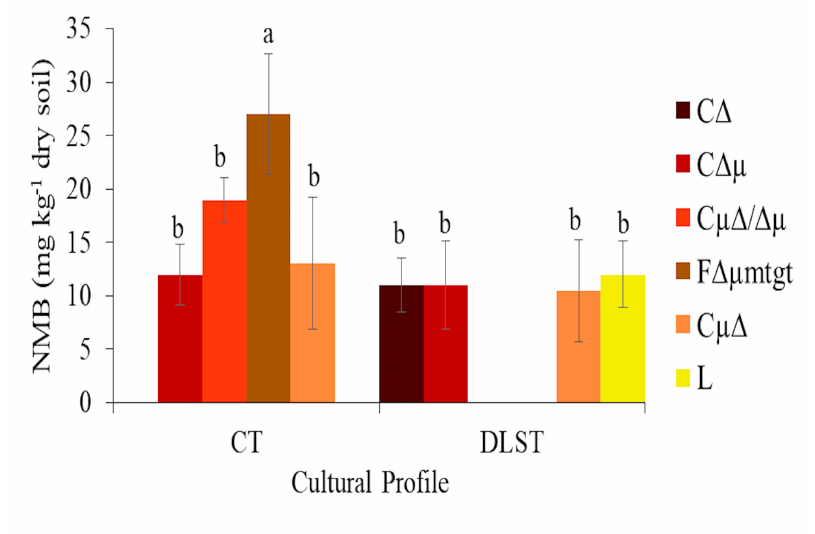
Figure 6. Nitrogen microbial biomass (NMB) in a dystrophic Red-Yellow Latosol under conventional tillage (CT) and deep localized soil tillage (DLST). Organization of clods: L = free soil volume, C = continuous soil volume, F = cracked soil volume, NAM = unaltered soil volume by use and management, mt = medium clods (7 cm Ø), gt = large clods (10 cm Ø). Internal states of clods: μΔ = porous with indications of compression, μΔ/Δμ = medium porosity, Δμ = compact with some porosity, Δ = compact with no visible porosity to the naked eye. Bars indicate the mean standard error. Volumes of soil with the same letter for different soil tillage systems did not differ statistically in Tukey’s test (p ≤ 0.05).